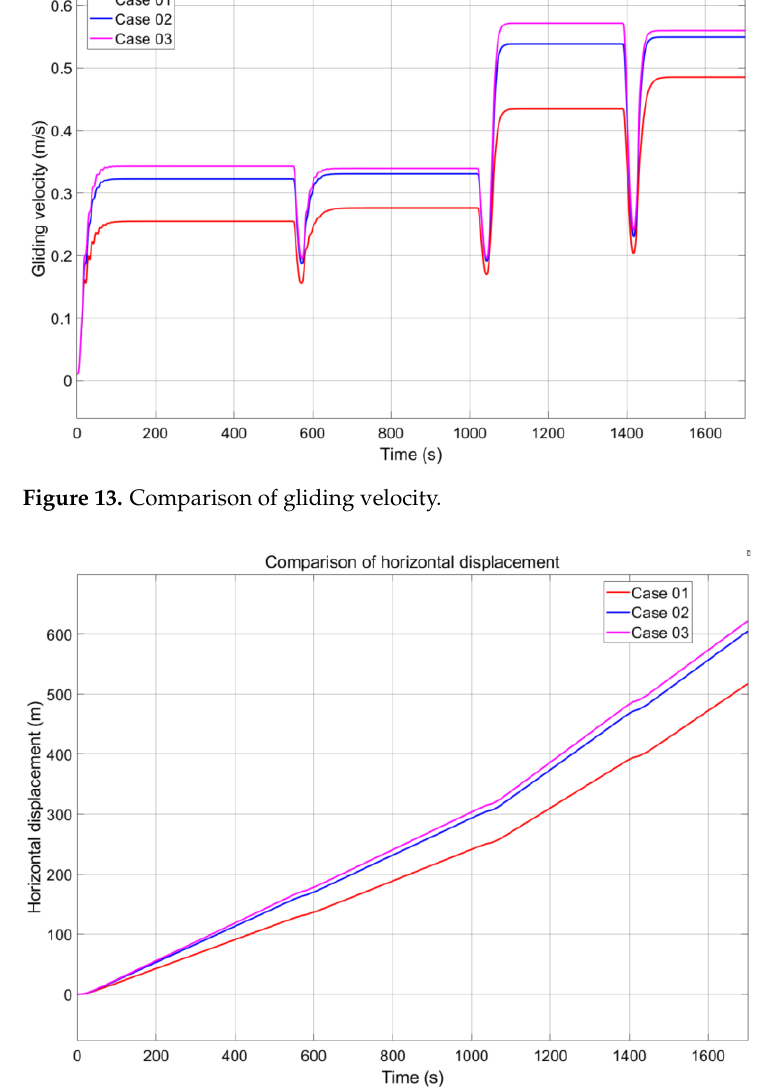
Figure 14. Comparison of horizontal displacement.